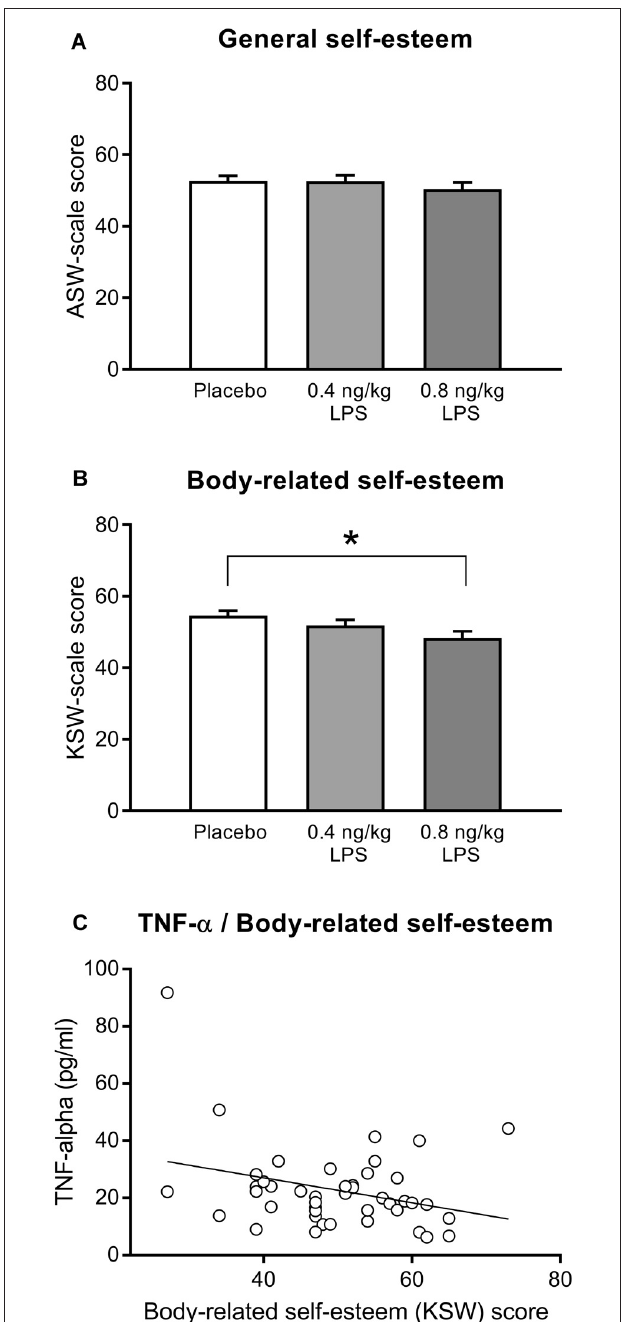
FIGURE 3 | General self-esteem (A) and body-related self-esteem (B) were assessed with the validated German Multidimensional Self-Worth Scale (MSWS) questionnaire (see text for details) 3 h after injection of either 0.8 or 0.4 ng/kg body weight LPS, or saline (placebo group). Exploratory correlation analysis within the LPS group (C) indicated a significant association between body-related self-esteem and TNF- α plasma concentration 3 h after injection ( r = − 0.31, p < 0.05; for details, see text). ∗ p < 0.05, result of Bonferroni-corrected post hoc t -test. For results of ANOVA, see text. association between body-related self-esteem and inflammatory parameters including IL-6 ( r = − 0.23, p = 0.13), CRP ( r = −